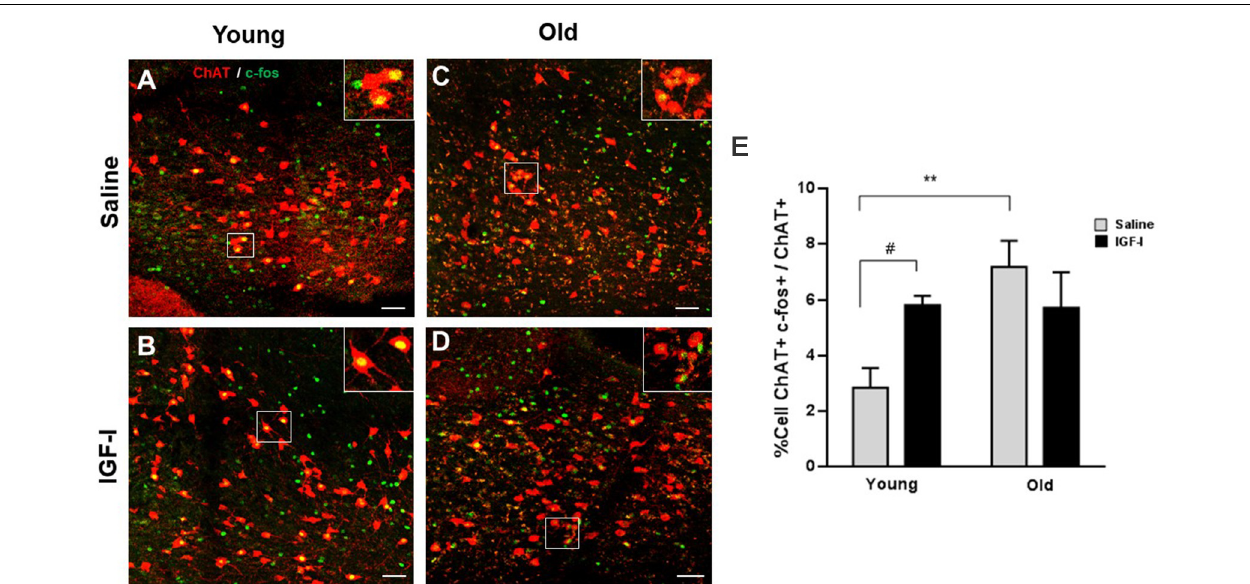
FIGURE 2 | Expression of c-fos in cholinergic neurons of young and old mice. (A–D) Representative photomicrographs of HDB area are shown, with a high density of ChAT+ neurons (red) and c-fos expression (green), after saline or IGF-I i.p. injections in young (A,B) and old (C,D) animals. The bar is 50 µ m. (E) Plot of the percentage of total ChAT+/c-fos+ cells. While young mice show an increased c-fos expression in ChAT neurons after i.p. IGF-I (1 µ g/kg; n = 3 mice per group; from 2.85% ± 0.7 to 5.80% ± 0.32; # p < 0.05), old mice do not show significant decreased expression (from 7.16% ± 0.94 to 5.17% ± 1.27; p = 0.2792). Note that old mice treated with saline showed higher activation of c-fos than young saline (** p < 0.01). Two-Way ANOVA, and Fisher’s LSD comparison test by